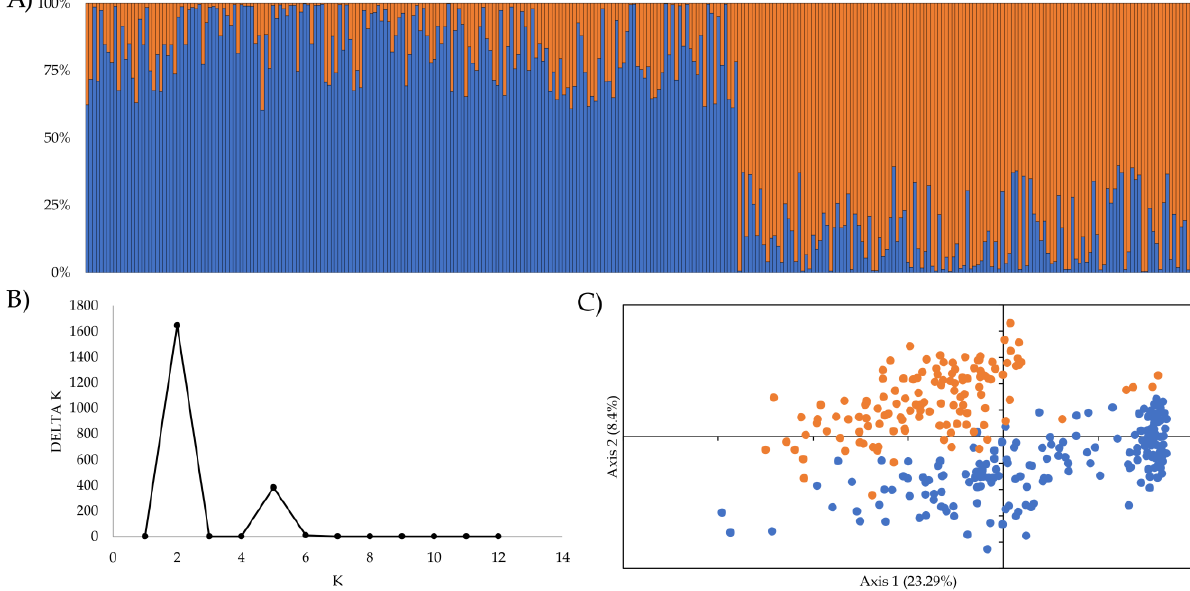
Figure 1. Population structure analysis for 316 spring wheat cultivars. ( A ) Genetic structure inferred by a Bayesian clustering model using STRUCTURE. The proportion of colored segments (light blue and orange) indicates the proportion of the genome extracted from the two sub-groups (cluster 1 and cluster 2, respectively). ( B ) Delta K values for different numbers of populations assumed (K) in the STRUCTURE analysis. ( C ) Principal Component Analysis (PCA) shows the 316 cultivars spatially distributed in relation to the first two main components. The cultivars were colored according to cluster matching the structure population (blue for cluster 1 and orange for cluster